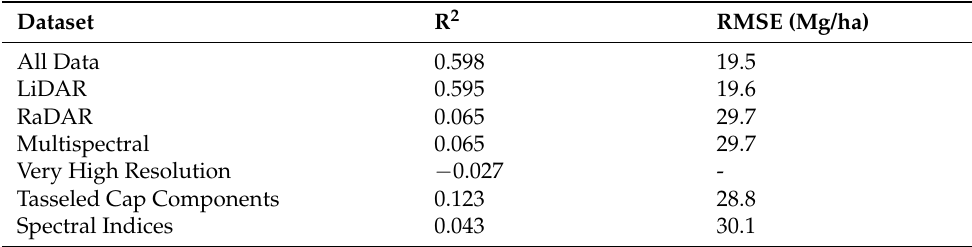
Table 2. Accuracy summary of sub-dataset testing.